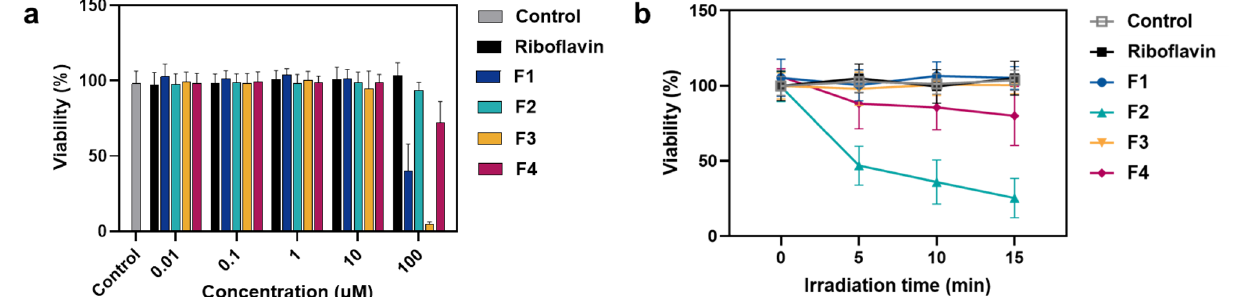
Figure 5. In vitro toxicity of F1-4 towards human cells. ( a ) In vitro cytotoxicity effect of F1–4 and riboflavin on WI-38 cells after 24 h incubation determined by MTS assay. Data are expressed as the mean ± SD of three biological replicates. ( b ) Light-induced toxicity of WI-38 cells treated with F1 – F4 and riboflavin (10 µM) irradiated for 0–15 min with 1 × 10 5 lx white LED light. Data are expressed as the mean ± SD of three biological replicates. Control = 0.1% DMSO in